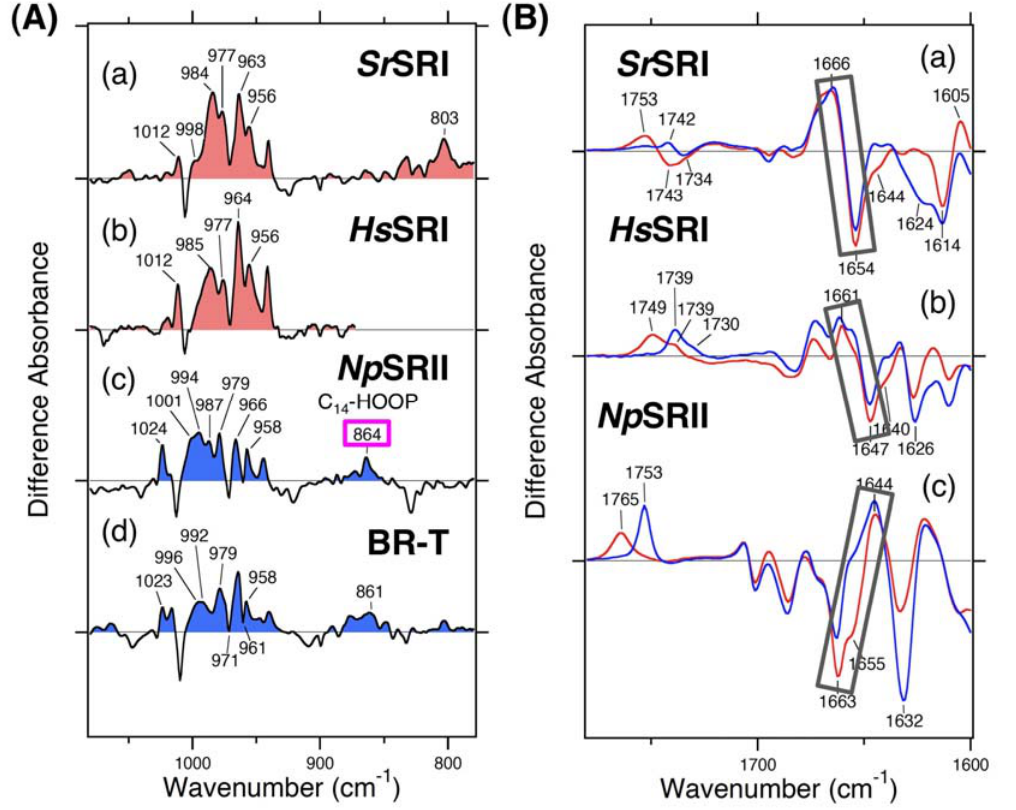
Figure 6. (A) Spectral comparison of the HOOP vibrations of the retinal chromophore upon formation of the K intermediate. Sr SRI minus Sr SRI (a) and Hs SRI minus Hs SRI K K (b), difference infrared spectra measured at pH 7.0 and 8.5, respectively. The spectrum of minus Hs SRI spectra are multiplied by 4.2 Hs SRI was deleted at < 872 cm -1 . The Hs SRI K for the sake of comparison. The samples were hydrated with H O. The SRII minus SRII 2 K (c) and BR-T minus BR-T (d) difference FTIR spectra are reproduced from reference [70] K and [83], respectively, for comparison. (B) Spectral comparison of the amide-I vibration upon formation of the M intermediate. Sr SRI minus Sr SRI (a) difference infrared spectra M measured at 260 K at pH 7.0 in the 1,780–1,600 cm -1 region. The samples were hydrated with H O (red) or D O (blue). The Hs SRI minus Hs SRI (b) and SRII minus SRII (c) 2 2 M M difference FTIR spectra are reproduced from reference [54] and [72], respectively, for comparison. Adopted from reference